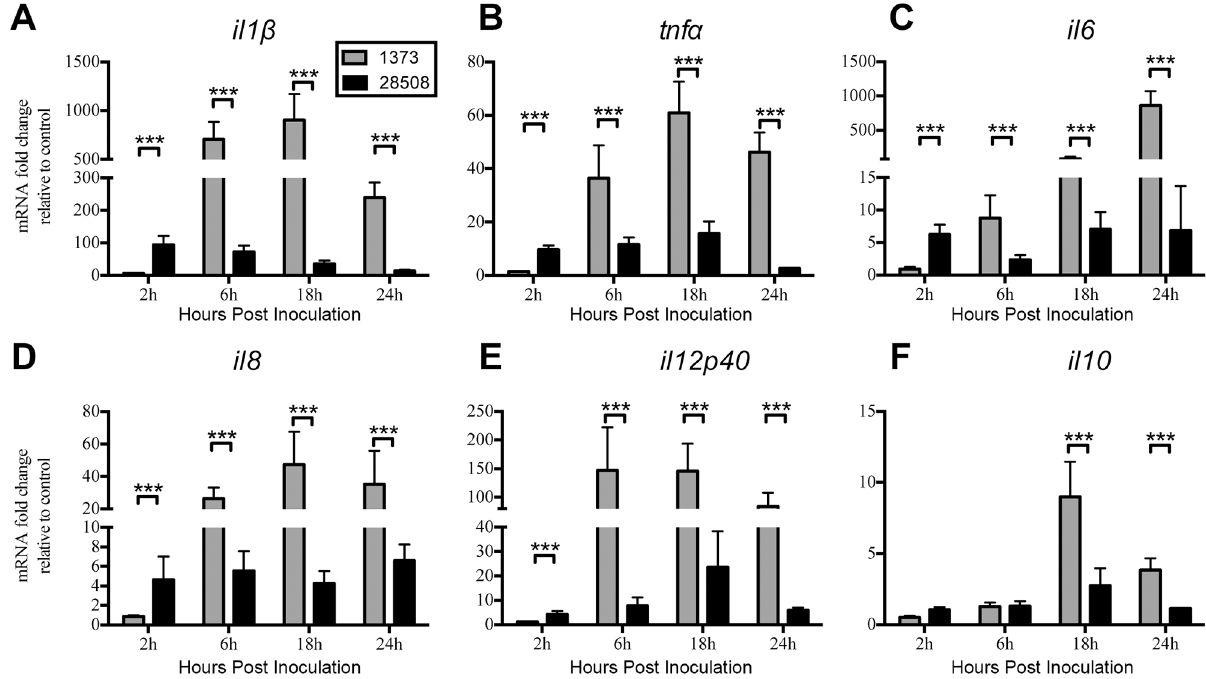
Fig 2. Expression of proinflammatory cytokine gene transcription in MDM Φ s inoculated with high and low virulence BVDV2 strains. MDM Φ s were differentiated in 96 well plates for 7 days and inoculated with BVDV2 strains in duplicate at an MOI of 1 with RNA harvested at 2, 6, 18, and 24 h after inoculation. Cytokine mRNA was analyzed by qPCR using ribosomal protein s9 (RPS9) as an endogenous control with fold change expressed relative to uninfected control MDM Φ s harvested at the corresponding time points. il1 β (A),